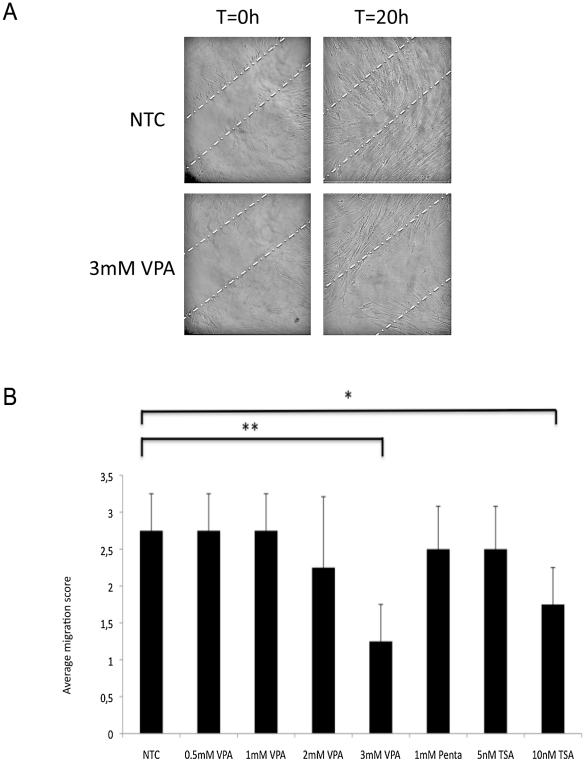
Effect of VPA on human pericyte migration.Effect of exposure of different concentrations of VPA on human pericyte migration in a wound scratch assay was studied. (A) Representative images of pericyte cultures in the wound scratch assay at t = 0 and at t = 20 h (white dotted lines designate the borders of the wound scratch), exposed to 2 mM VPA and NTC pericytes. (B) Migration scores calculated as outlined in materials and methods were determined in pericyte cultures exposed to different concentrations of VPA, TSA or Penta. Mean ± SD, n = 4. T-test * p<0.05, ** p<0.01, *** p<0.001.